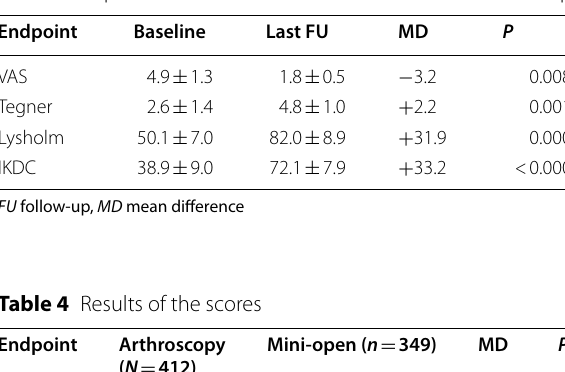
Table 3 Improvement of PROMs from baseline to last follow-up